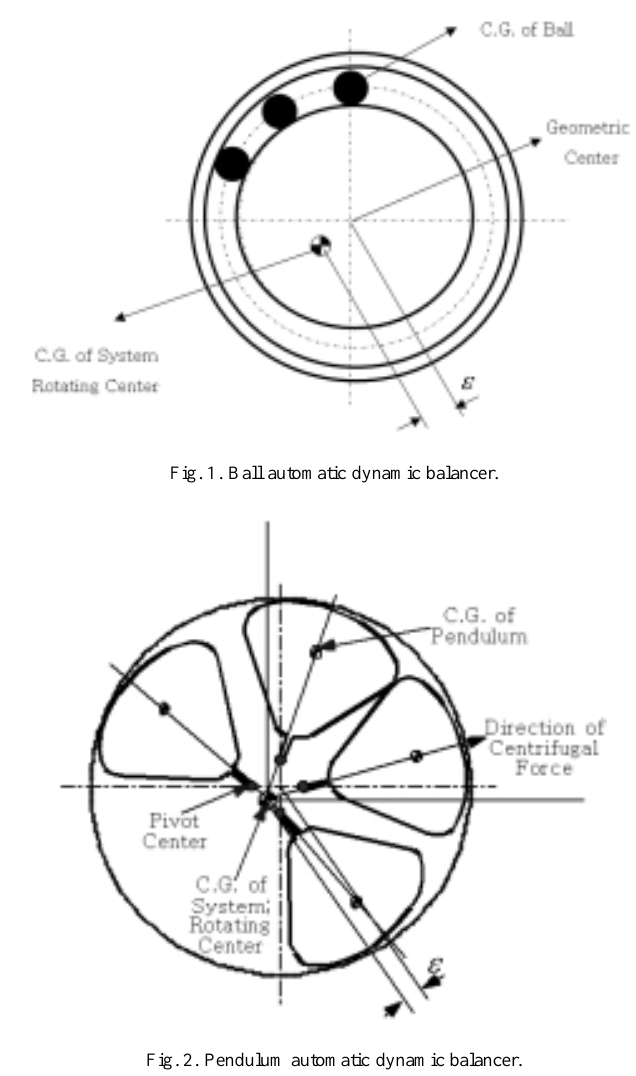
Fig. 2. Pendulum automatic dynamic